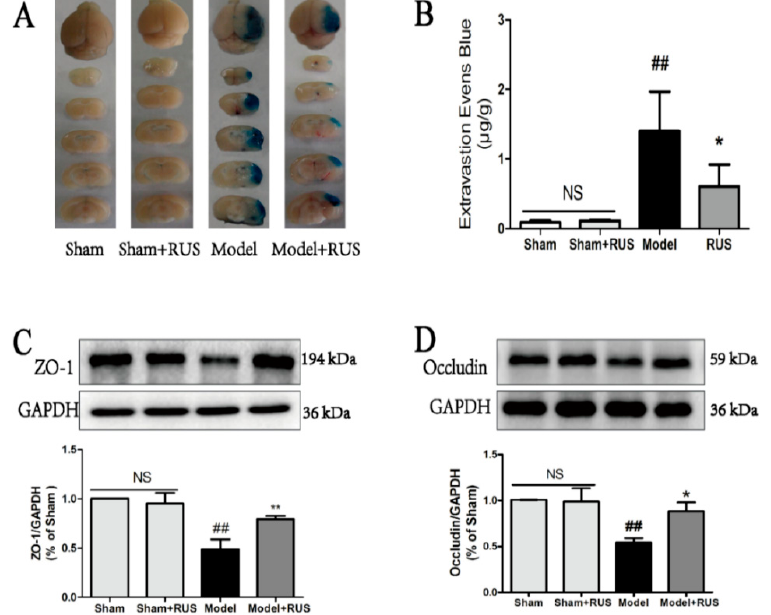
Figure 3. Effects of ruscogenin on BBB permeability and the expression of tight junction proteins in mice following MCAO/R. ( A , B ) Representative gross appearance of EB-stained brain section in mice and quantitative analysis of EB extravasation by spectrophotometry ( n = 6); ( C , D ) representative Western blot bands and quantitative analysis of the expression levels of ZO-1 and occludin in different groups. The band intensities were measured using scanning densitometry. The data were normalized to glyceraldehyde-3-phosphate dehydrogenase (GAPDH) expression ( n = 3). NS means “not significant”. The data are expressed as means ± SD. ## p < 0.01 vs. Sham, * p < 0.05, ** p < 0.01 vs. Model.